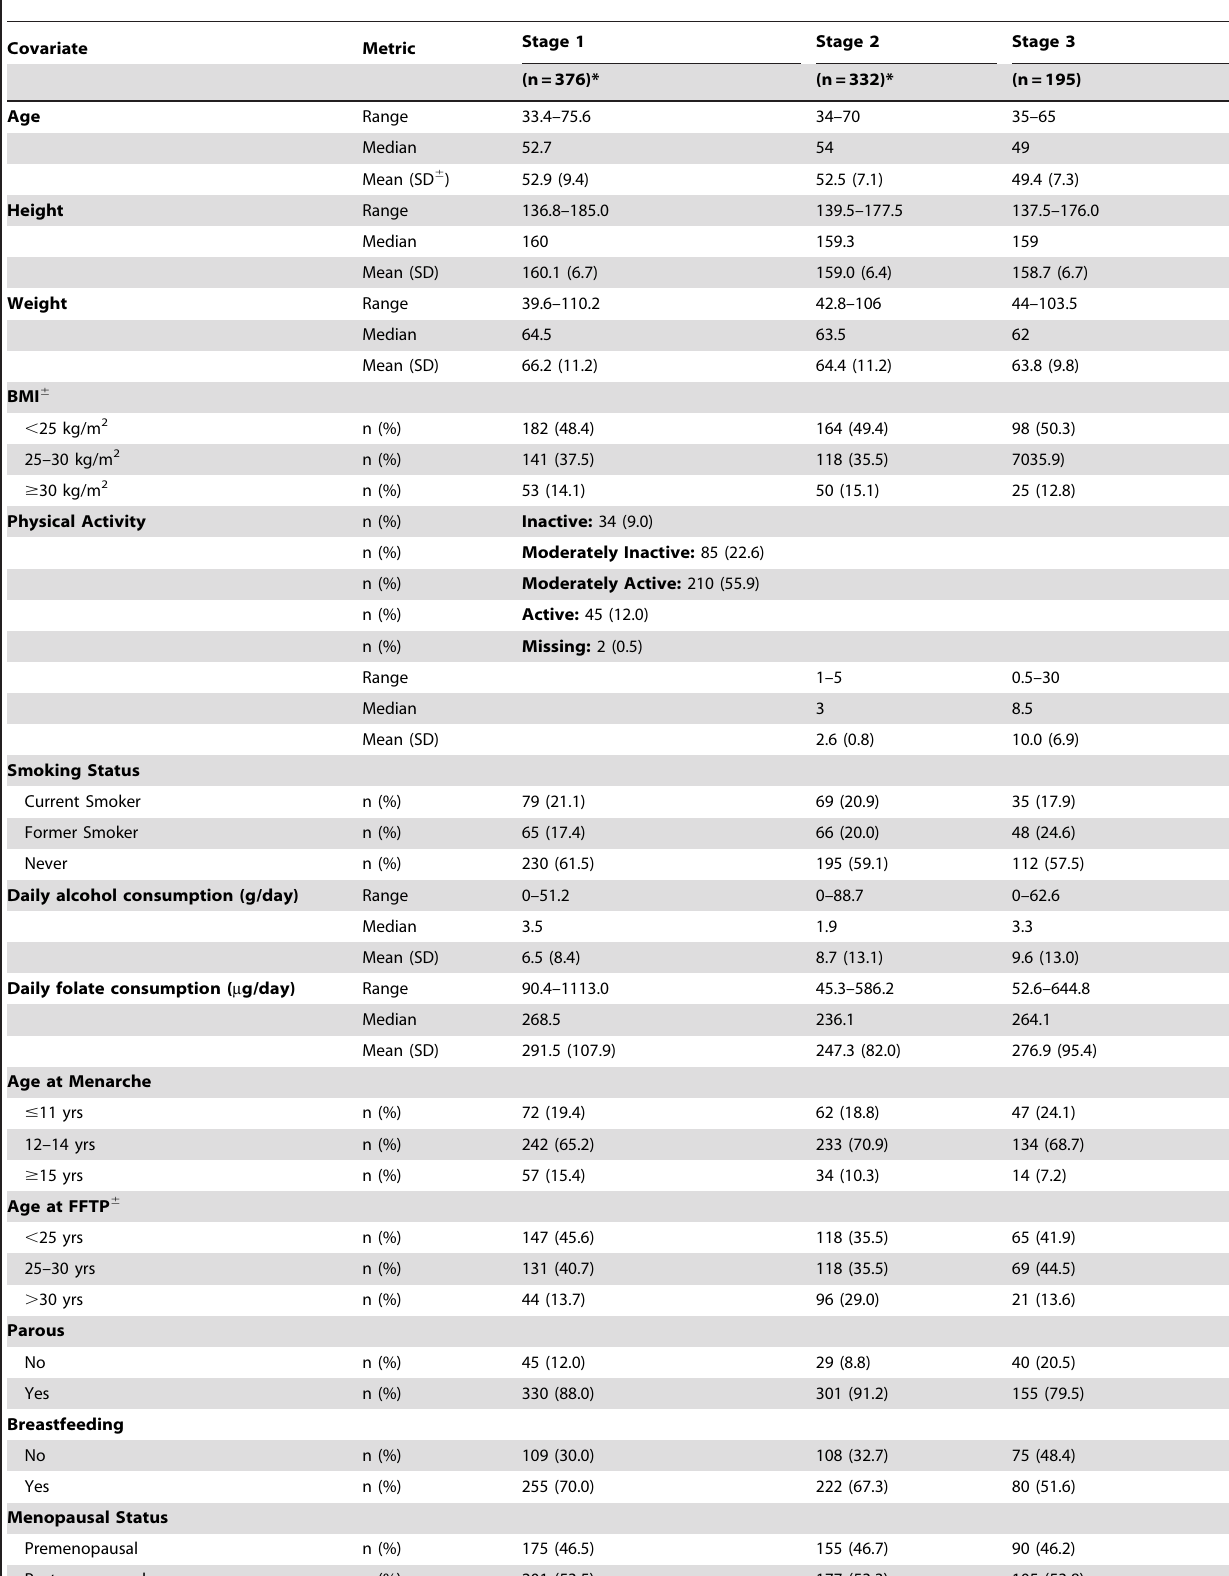
Table 1. Subject demographic, anthropometric, lifestyle, and reproductive characteristics, by analysis